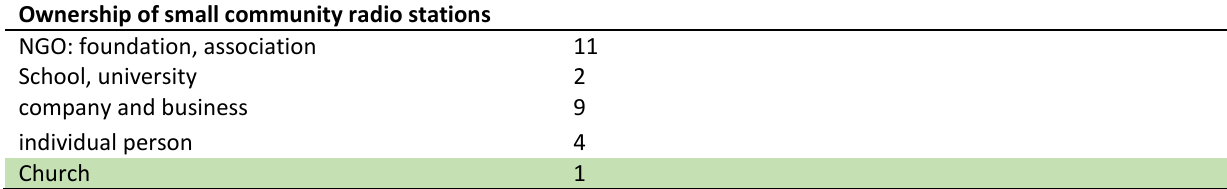
Table 2. Ownership of small community radio stations.